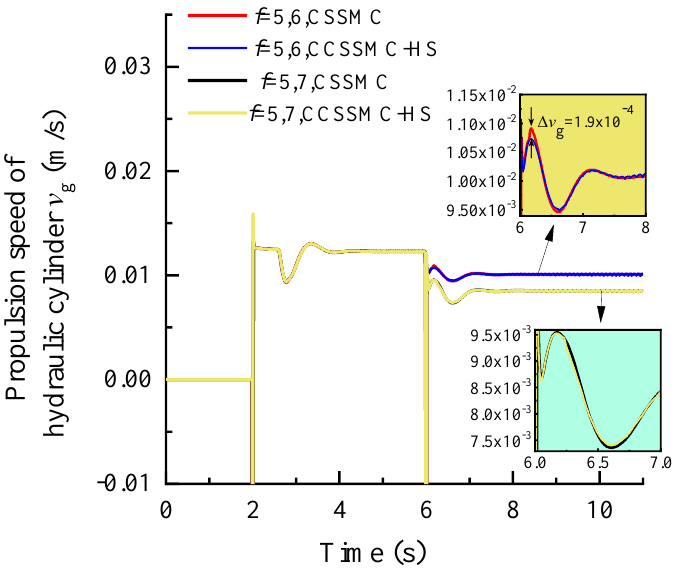
Figure 18. Variation curve of the hydraulic cylinder speed based on the CSSMC and CSSMC-HS.